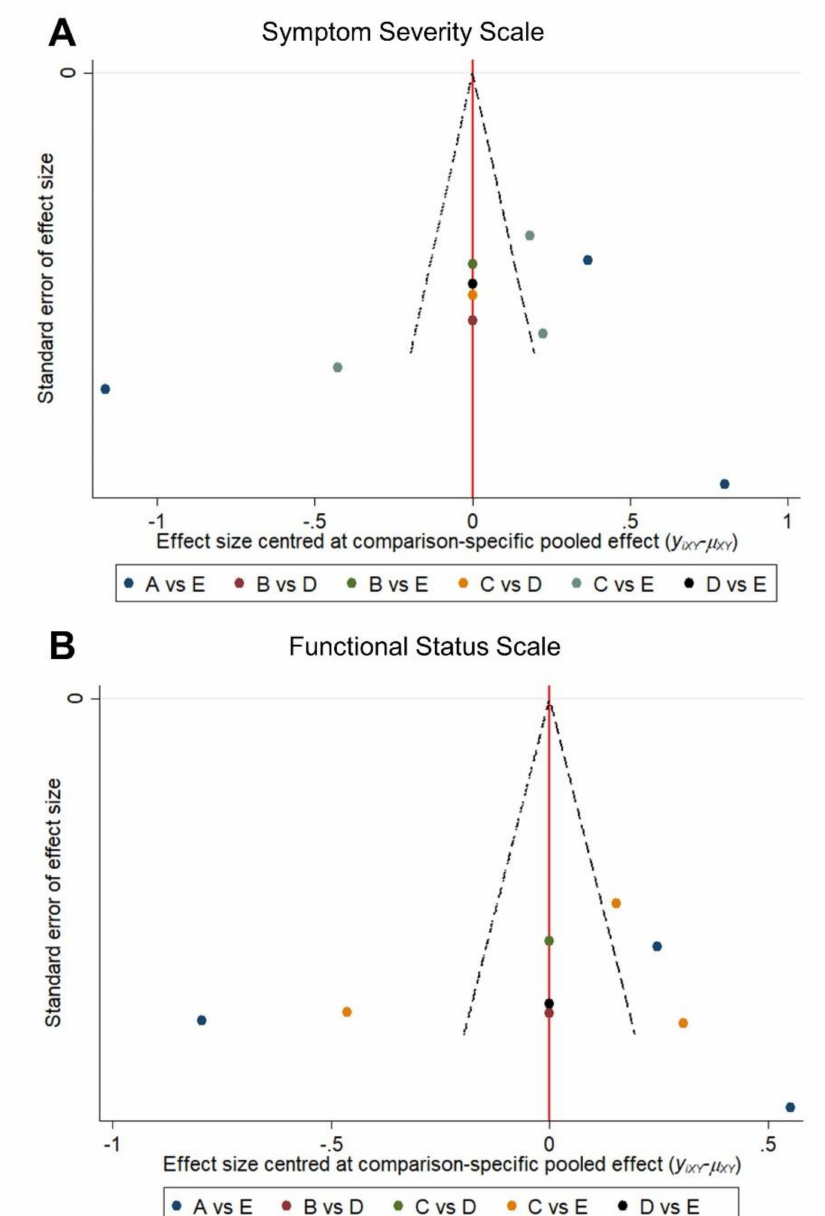
Figure 5. Funnel plot for the comparisons of the standardized mean di ff erence between di ff erent subgroups in terms of the ( A ) symptom severity scale and ( B ) functional status scale of the Boston Carpal Tunnel Questionnaire. A: splinting; B: saline; C: steroid; D: 5% dextrose; E: platelet-rich